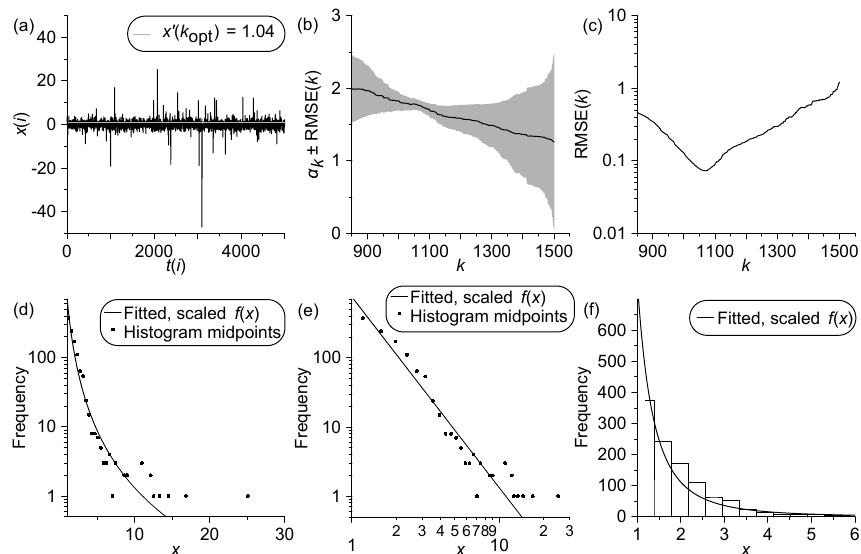
Figure 2. Application of heavy tail estimation with optimal order selection to artificial data: (a) time series (dark line), drawn from an AR(1) process with even spacing unity and stable distributed innovations ( n = 5000, τ = 1 . 5, α = 1 . 75); (b) sequence b α k (solid dark line) ± RMSE (k) (shaded) for the Hill estimator (right tail); (c) measure RMSE (k) ; (d) – (f) frequency plots showing densities and his- tograms at various axis scalings. The optimal order is k opt = 1071. The fitted heavy tail density function, f (x) , has been scaled such that for x > x (cid:48) (k opt ) , the tail probability, F(x) (Eq. 1), times n equals the number of extreme events (right tail). (Note that R f (x) = F(x)